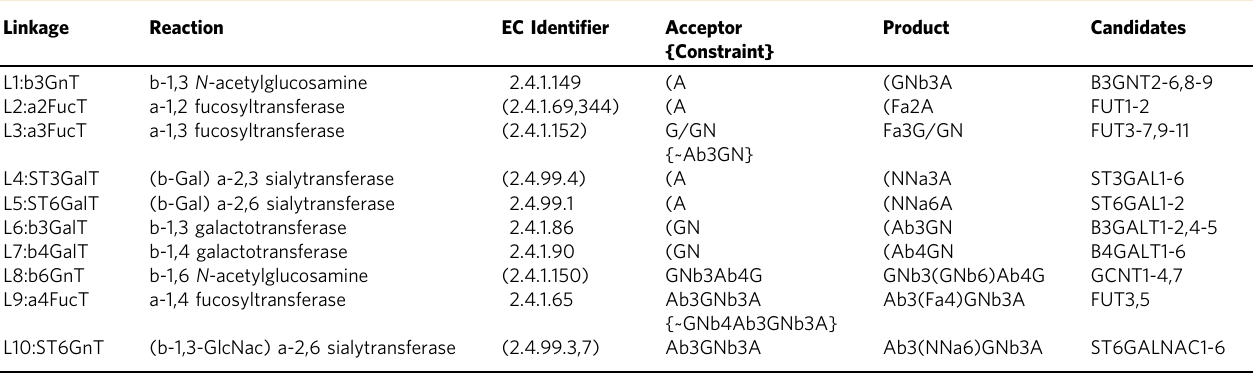
Table 1 Glycosylation reactions